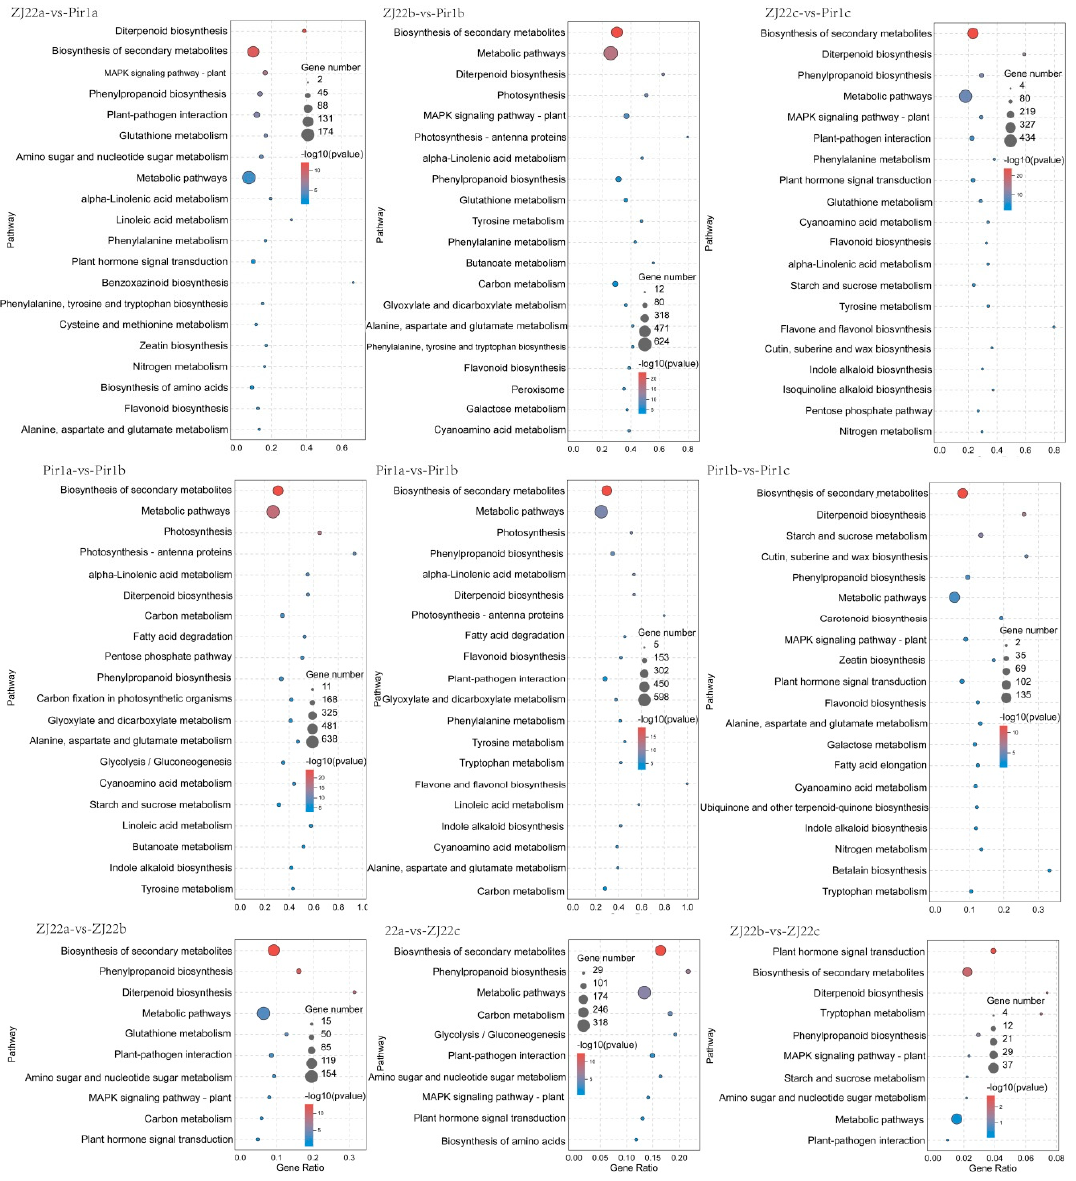
Figure 8. KEGG enrichments of the annotated DEGs. The left Y -axis indicates the KEGG pathway, and the X -axis indicates the rich factor. A high q-value is represented by blue, and a low q-value by red color. The rich factor is the ratio of the number of DEGs mapped to a certain pathway to the total number of genes mapped to this pathway.